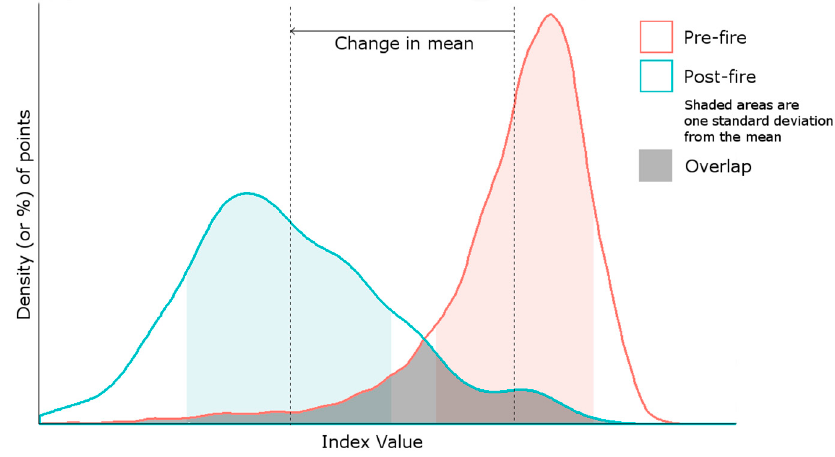
Figure 2. Conceptual diagram showing distributions of pre-fire and post-fire values.